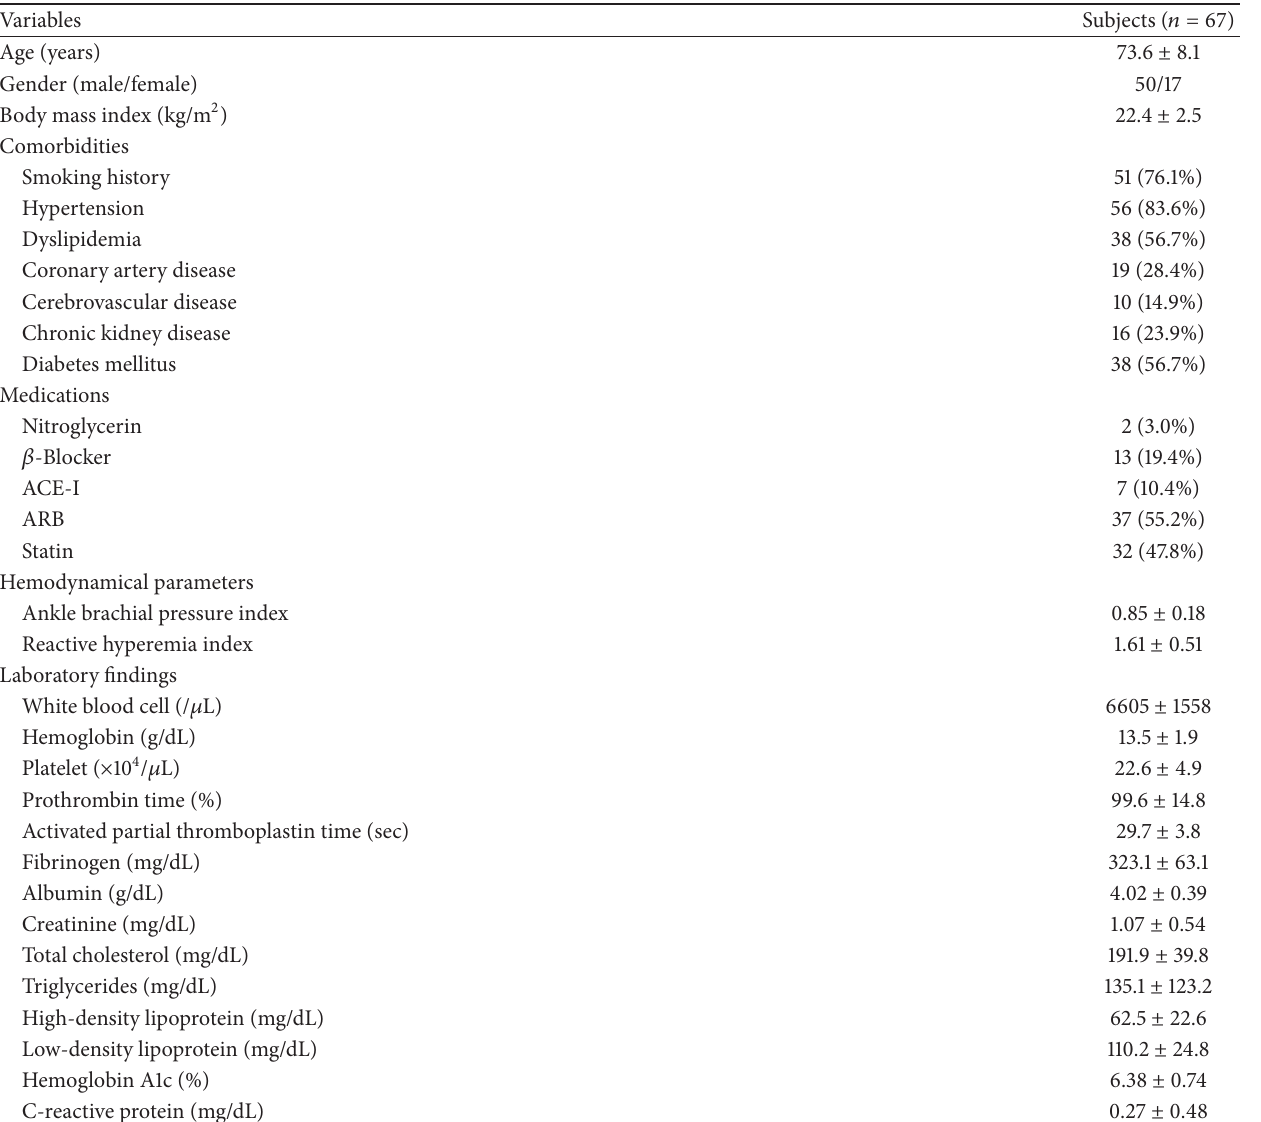
Table 1: Patients